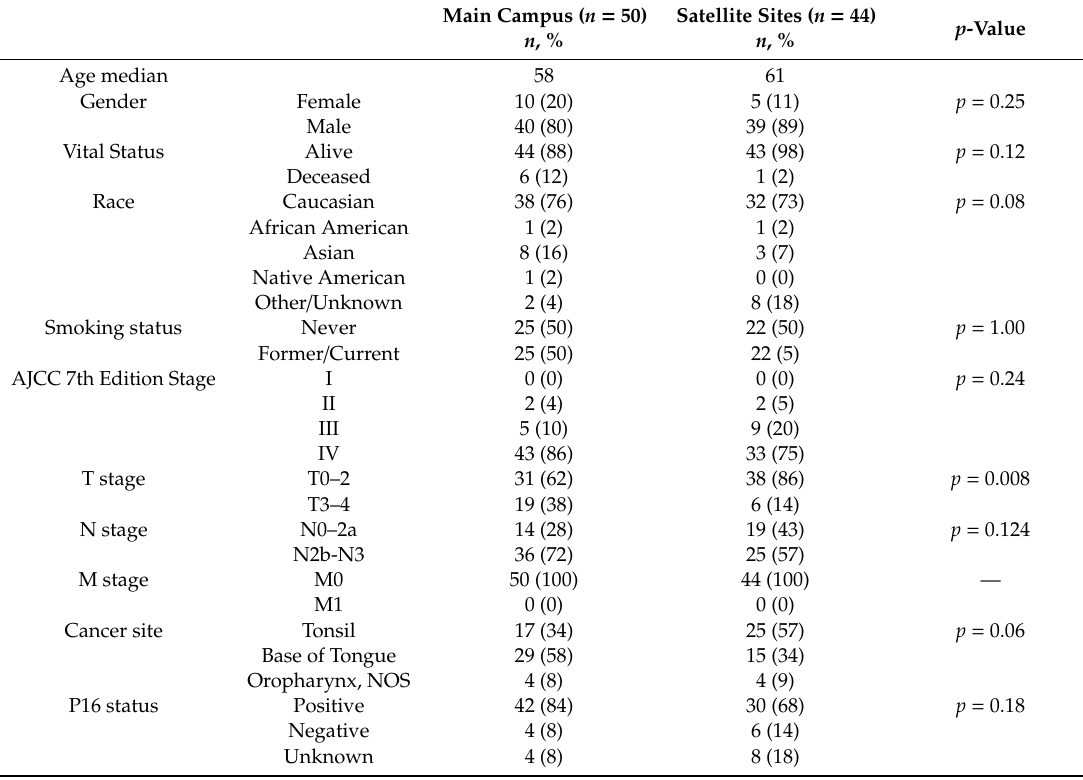
Table 1. Patient Characteristics by Treatment